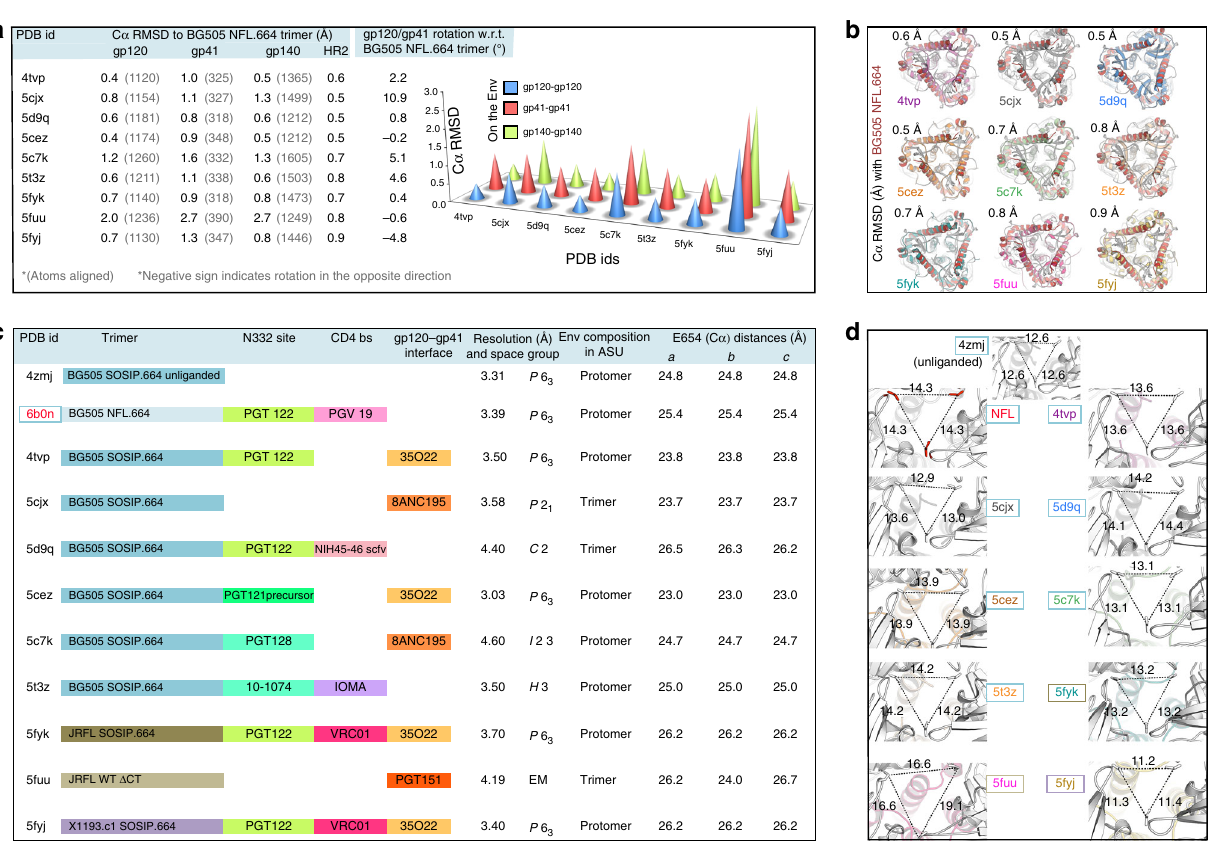
(Fig. 4c: sides a , b and c of Env base), and trimer apex opening ( ≥ 1 Å) when comparing different Env clades and designs to the unliganded structure (Fig. 4d). The BG505 SOSIP and NFL, with N332 and CD4bs sites both occupied, demonstrate identical apex opening (NFL and PDB 5T3Z 29 and 5D9Q 30 ).